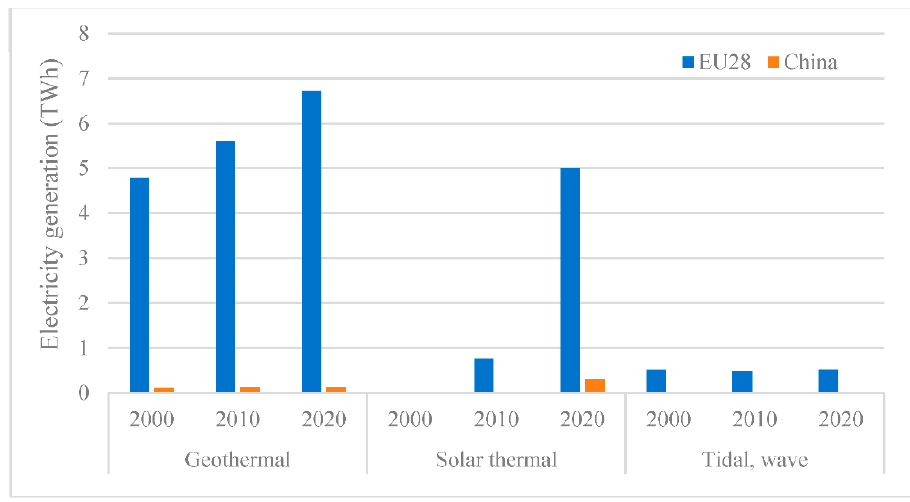
Figure 1. Renewable electricity generation in 2000, 2010 and 2020 in EU-28 and China (based on [26]).